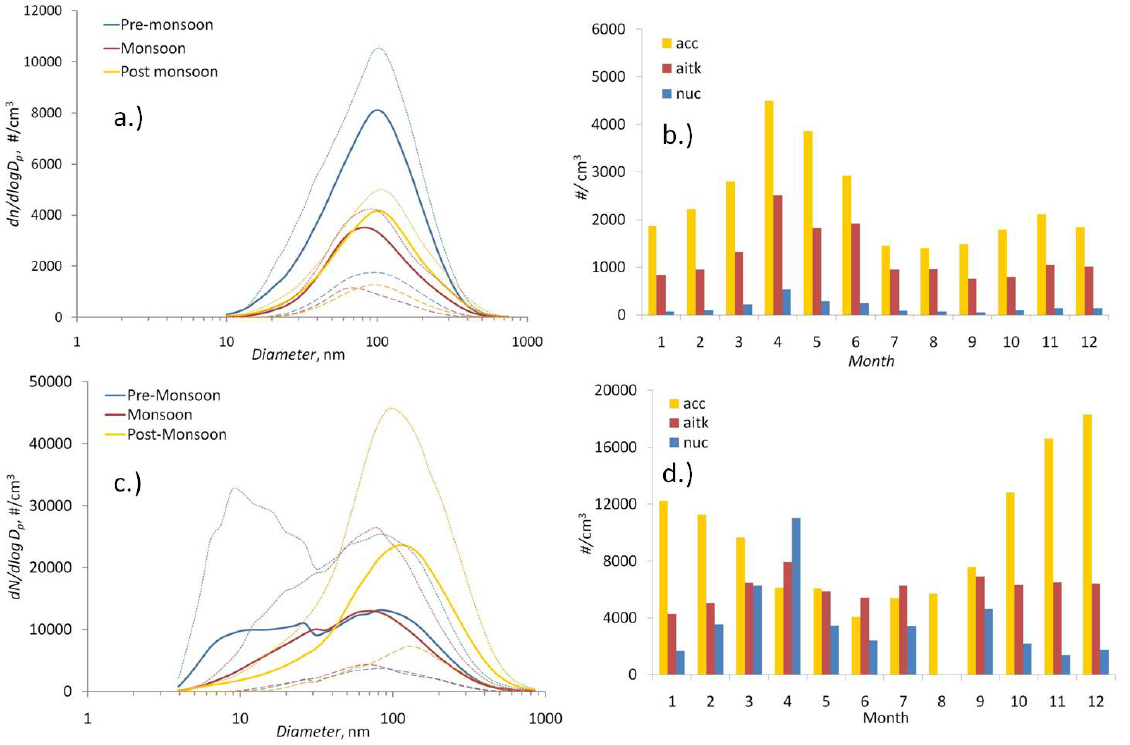
Fig. 4. Average size distributions for different seasons in (a) Mukteshwar, and (c) Gual Pahari. Solid lines are averages and dashed and dotted lines represent the 10th and 90th percentiles, respectively. Annual variation of the modal particle number concentrations in (b) Mukteshwar, and (d) Gual Pahari. Nucleation mode d p < 25nm, Aitken mode 25nm <d p < 75nm, accumulation mode d p > 75nm.